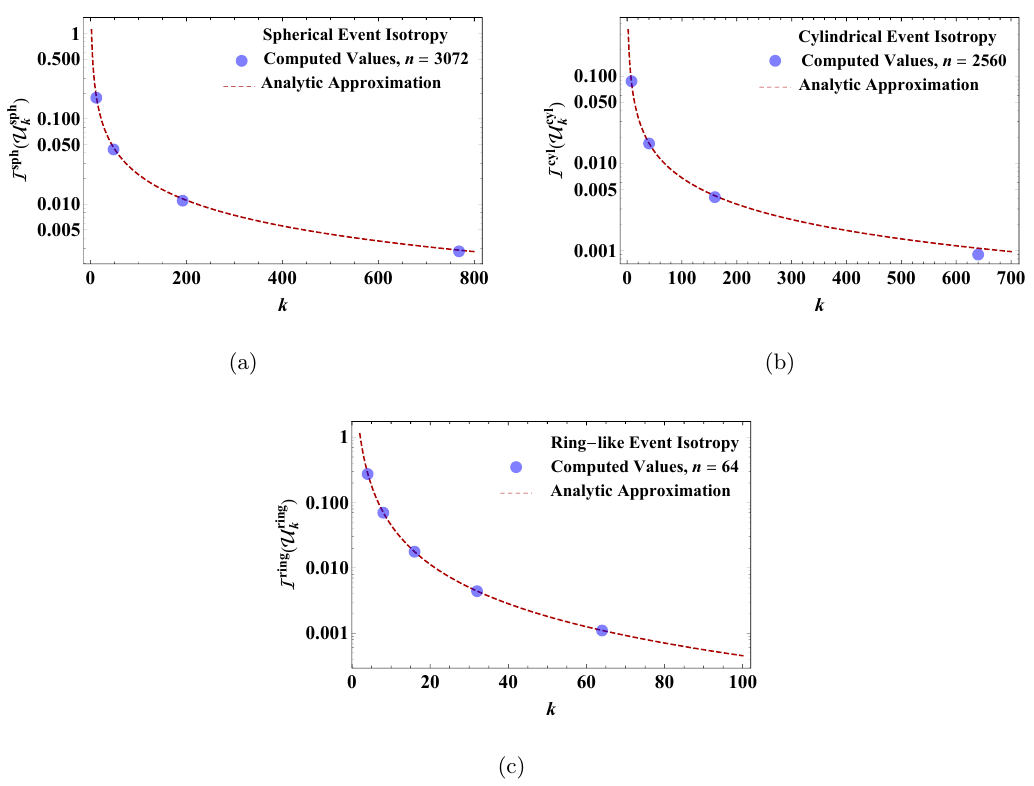
Figure 26 . The event isotropy of quasi-uniform k -body con(cid:12)gurations for the (a) spherical, (b) cylindrical, and (c) ring-like geometries. We (cid:12)nd good agreement between the analytic approxima- tion of event isotropy I (red line) and the numerically computed values of event isotropy (blue 1 markers) using (a) I sph , (b) I cyl , and (c) I ring 3072 2560 64